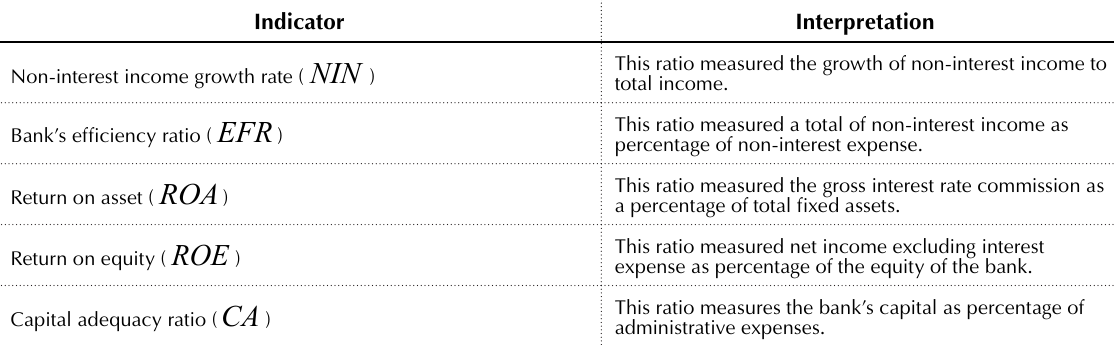
Table 9. Measure of AICABS